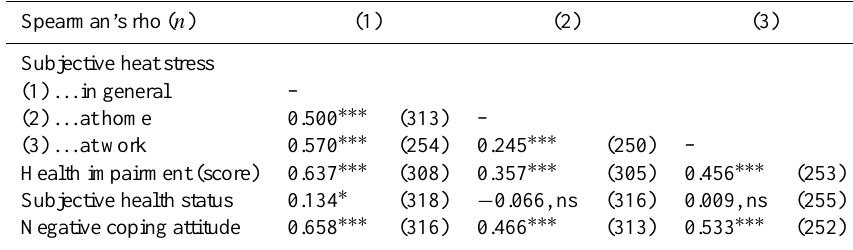
Table 2. Correlations (Spearman’s rho) for subjective heat stress.